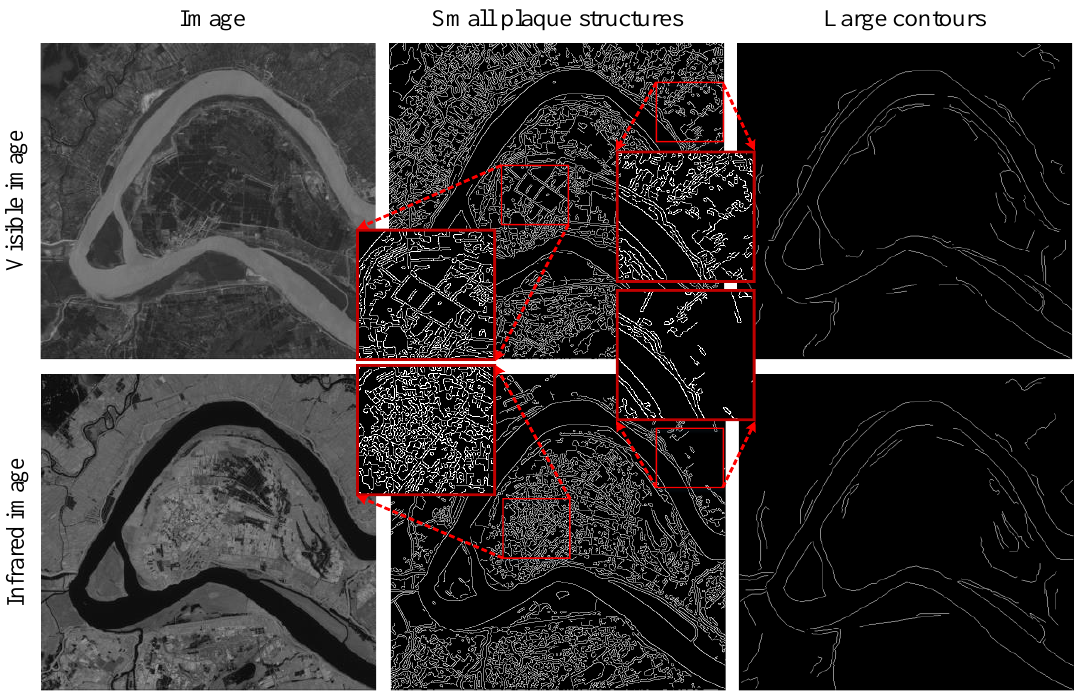
Figure 1. Comparison of small plaque structures and main structure of the large contours. The local details of small plaque structures are quite different (in red frame), whereas the main structures look similar between multimodal